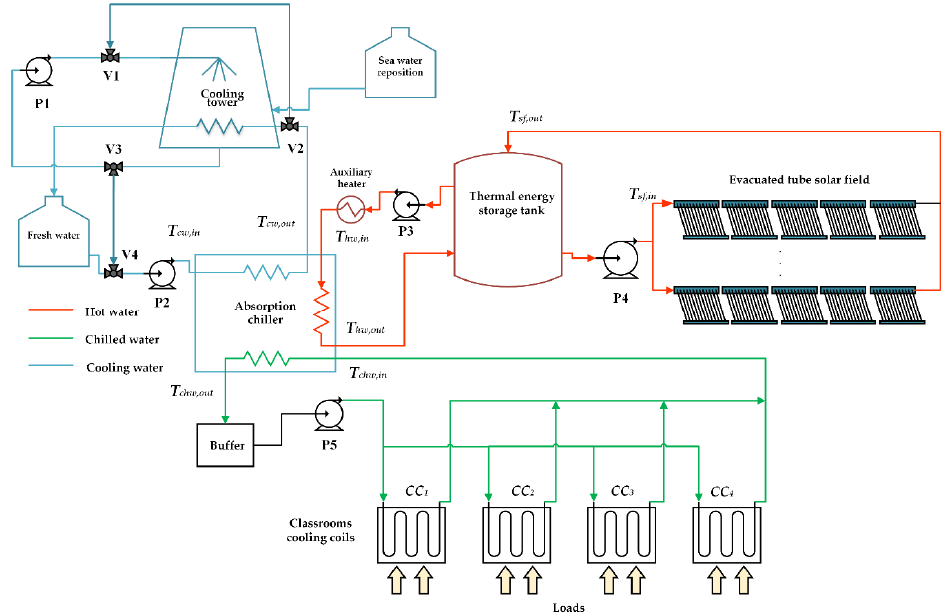
Figure 3. Schematic diagram of the equipment and circuits of the solar thermal cooling system.